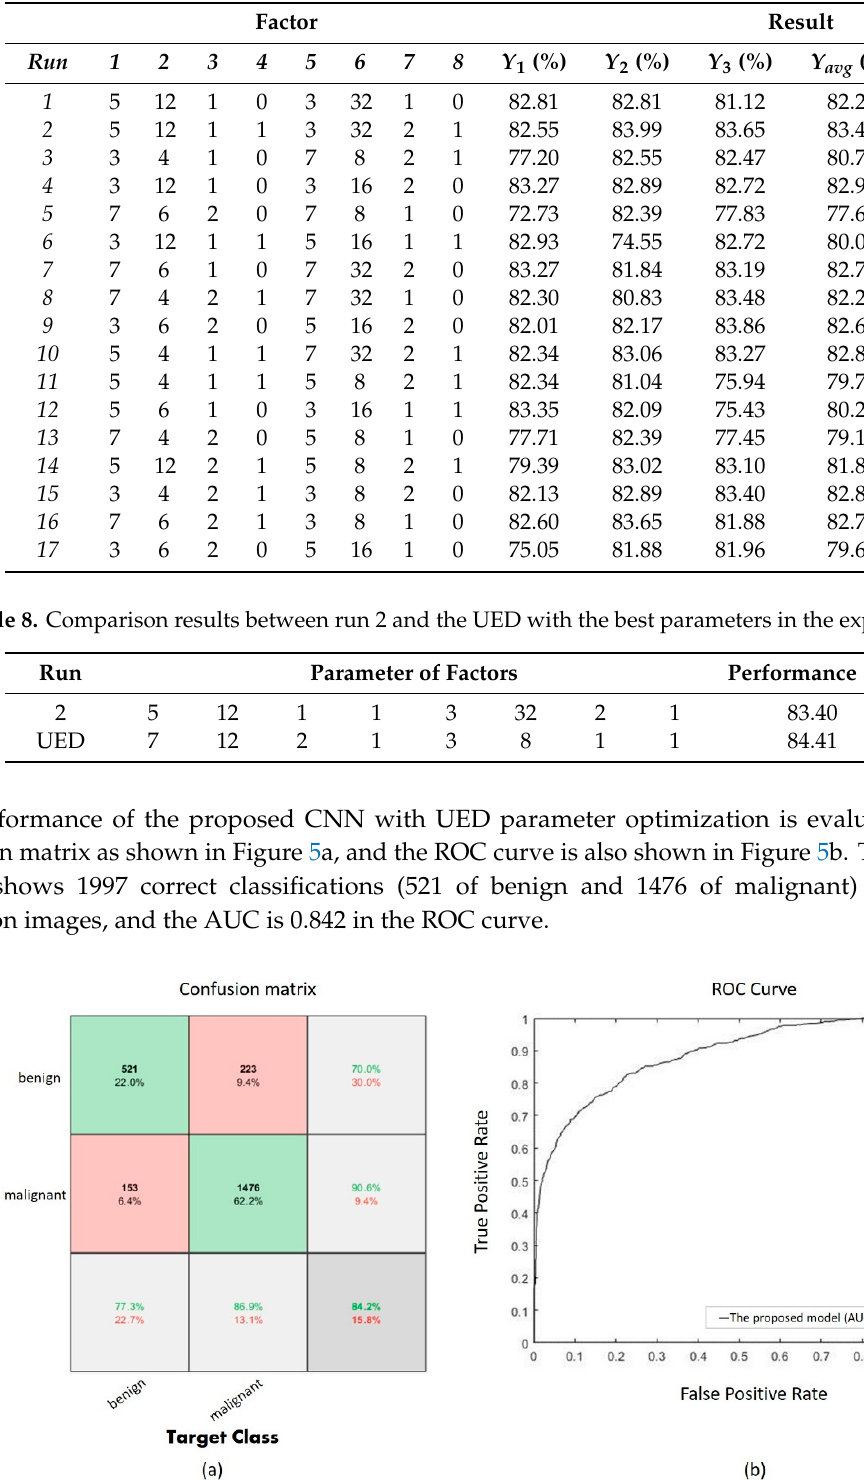
Table 7. Results of the CNN in BreakHis.